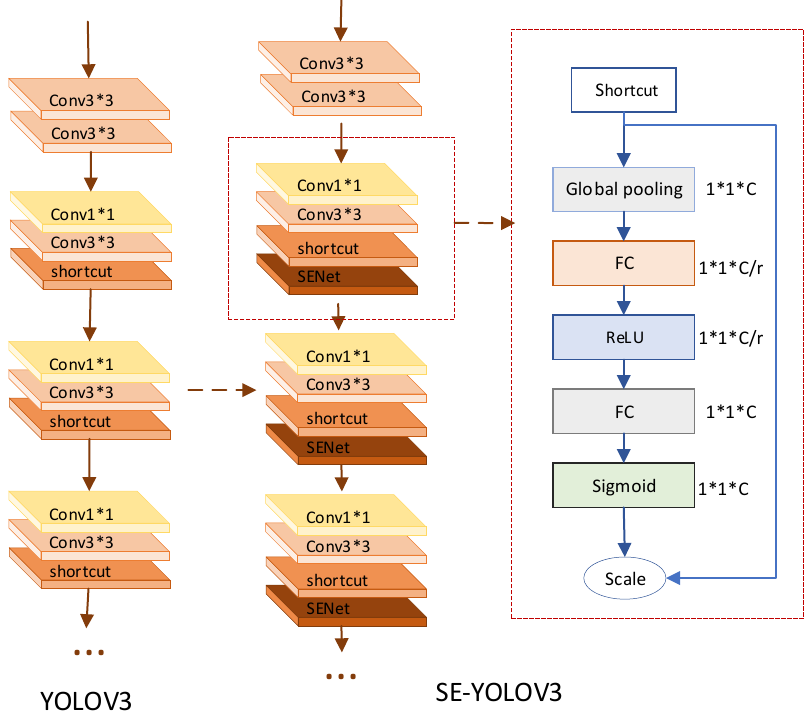
Figure 4. SE-IYOLOV3 structure. Table 1. Feature map information output from the SENet